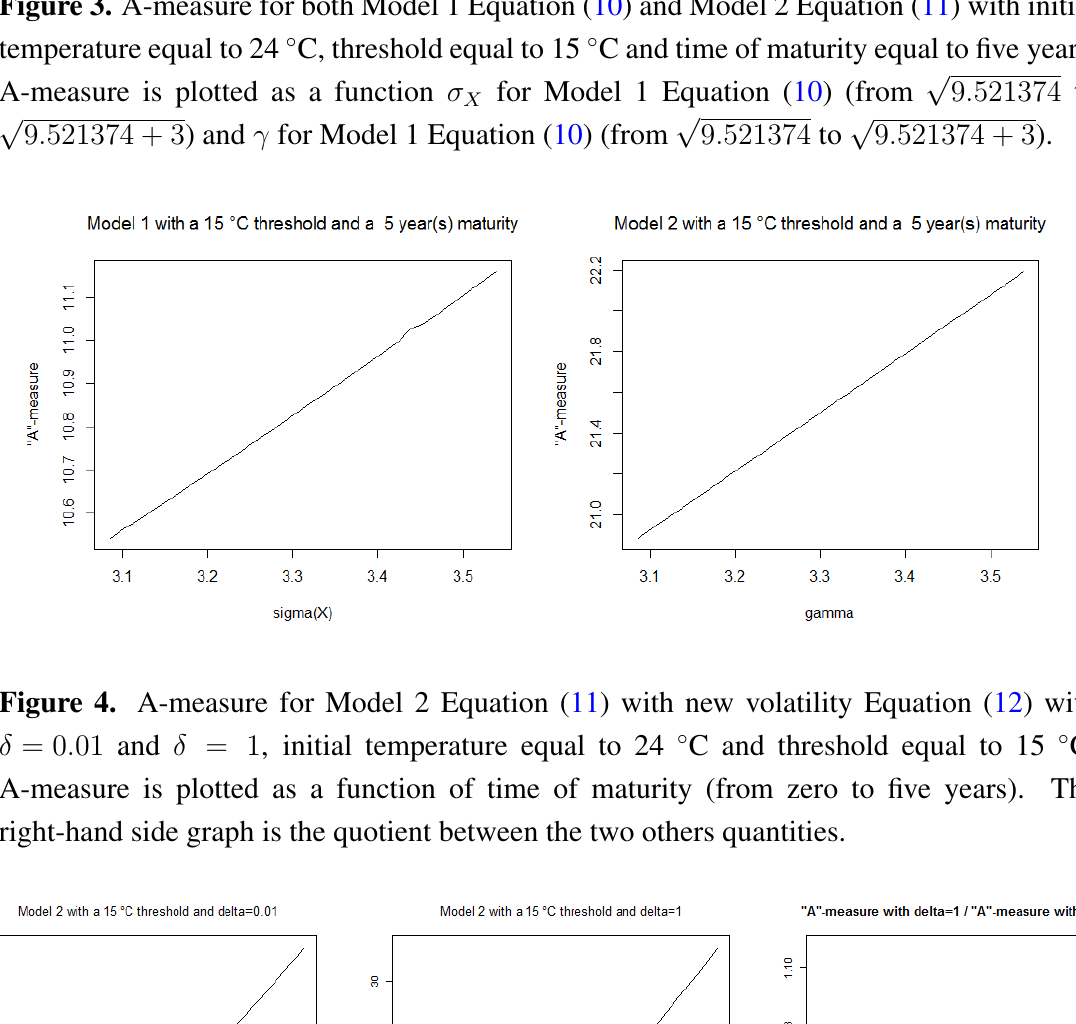
Figure 3. A-measure for both Model 1 Equation (10) and Model 2 Equation (11) with initial temperature equal to 24 ◦ C, threshold equal to 15 ◦ C and time of maturity equal to five years. A-measure is plotted as a function σ √ 9 . 521374 + 3 ) and γ for Model 1 Equation (10) (from